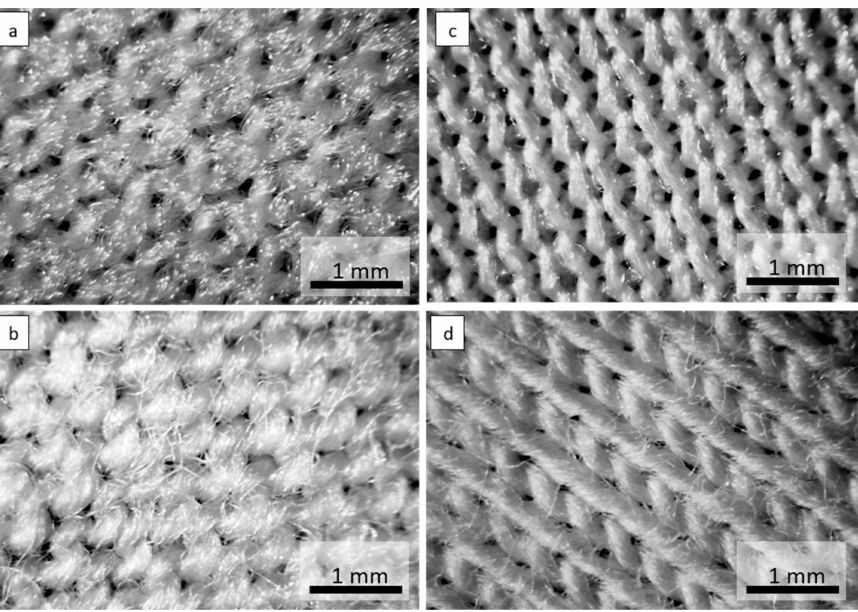
Figure 4. Optical microscope images of the materials: ( a ) knitwear interlock polyester 120 g · m − 2 , ( b ) knitwear single cotton 120 g · m − 2 , ( c ) knitwear interlock polyester 130 g · m − 2 , ( d ) knitwear single cotton 155 g · m − 2